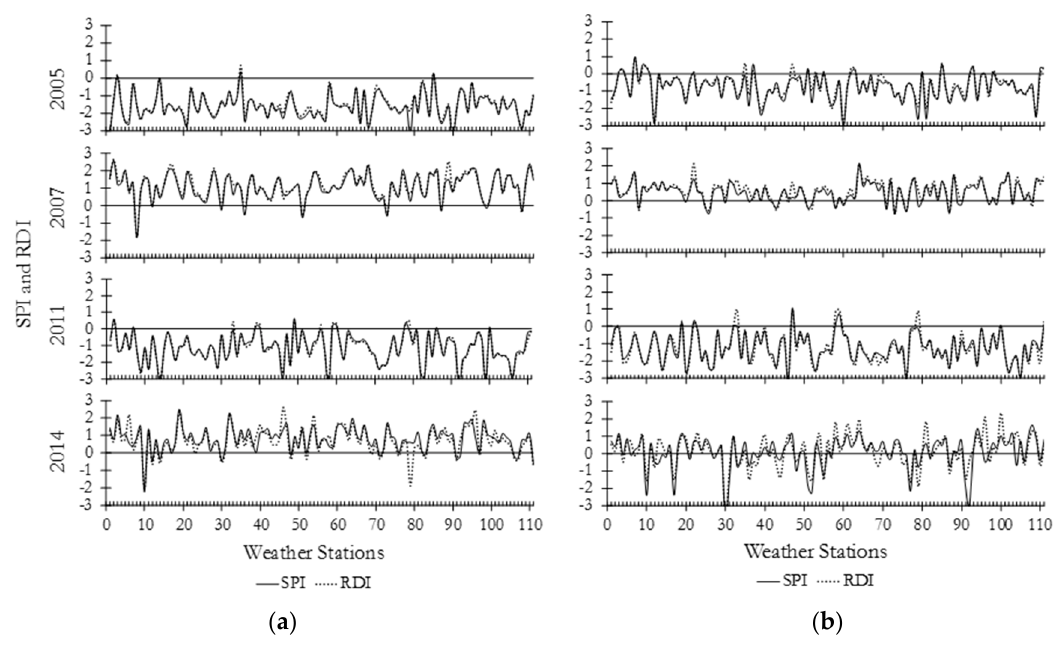
Figure 2. SPI and RDI values for all weather stations in 2005, 2007, 2011 and 2014: ( a ) 3 months